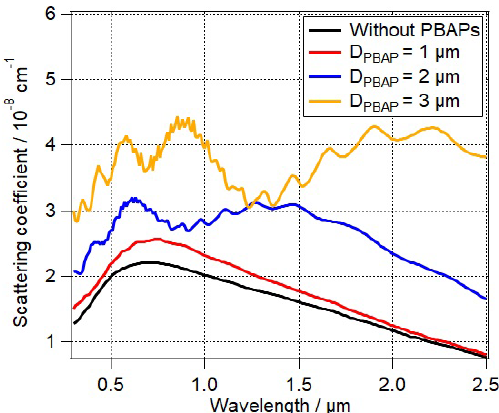
Figure 3. Total scattering coefficient for different PBAP diameters. The detailed input parameters can be found in Table 2. The black, red, blue, and brown lines correspond to S opt1 , S opt3 , S opt5 , and S opt6 ,